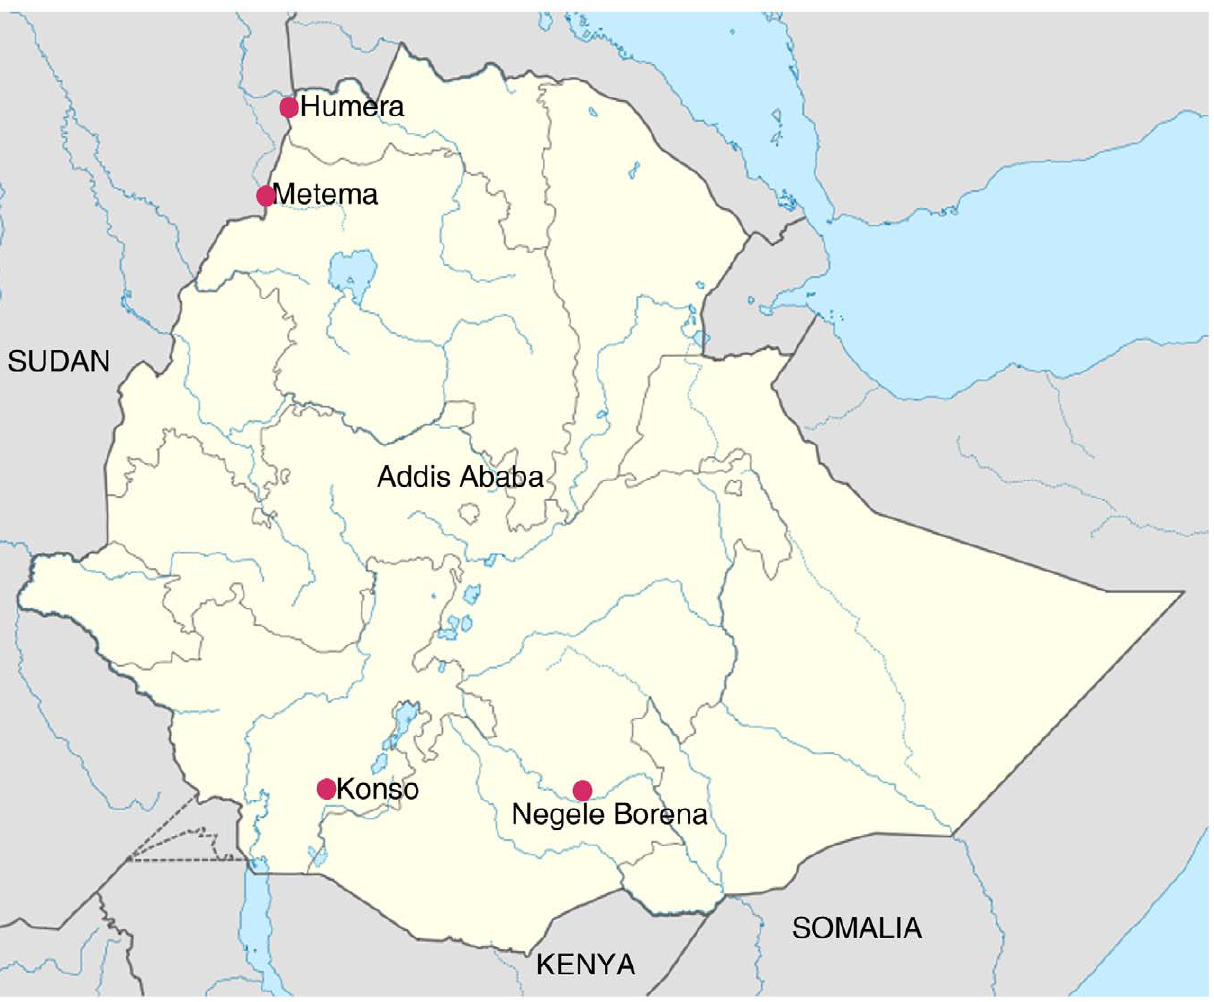
Figure 1. Map of Ethiopia. The VL foci in NE and SE are indicated. The NE foci are bordering the VL foci in Sudan, whereas the SE foci are bordering